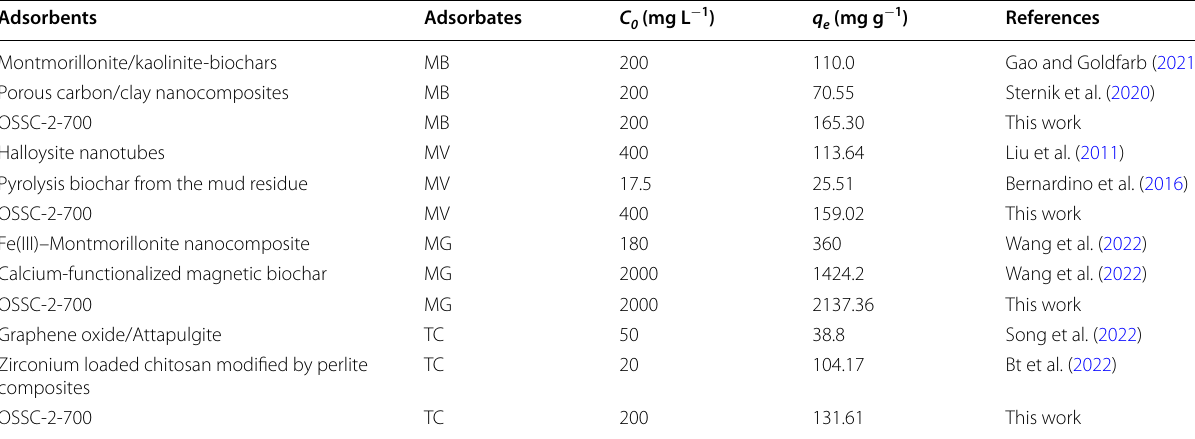
Table 3 Comparison the adsorption capacity of OSSC-2-700 to MB, MV, MG and TC with the similar biaochar/clay mineral composites